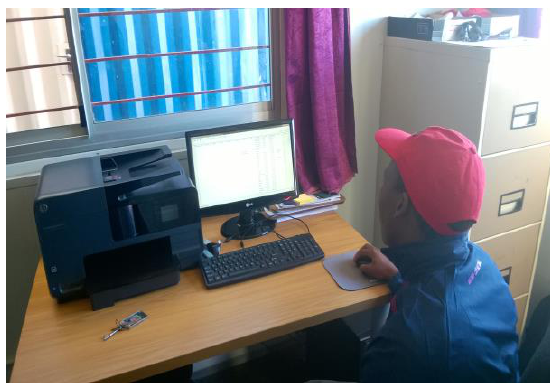
Figure 4. Community member updating the CiGIS